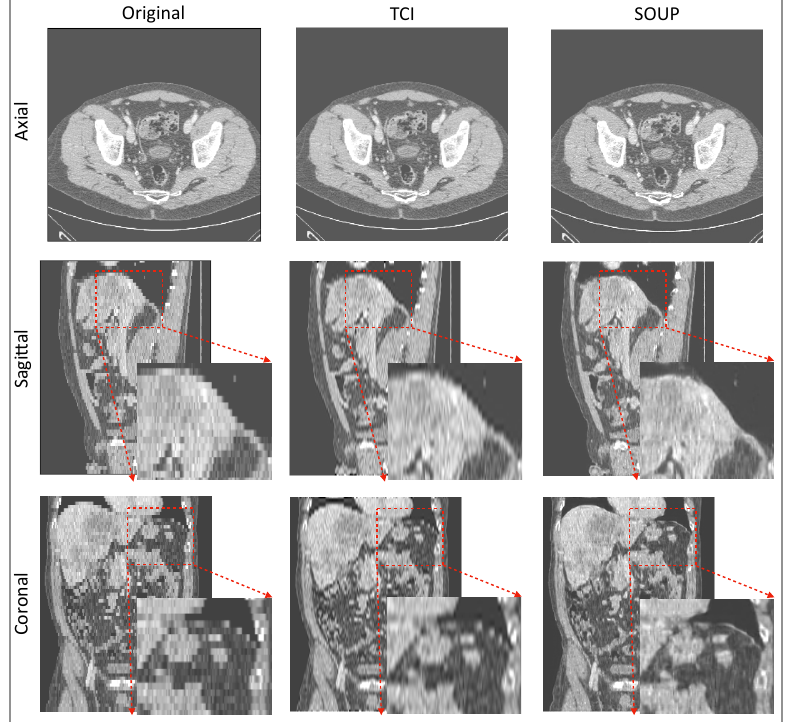
Figure 7. Another example of SR interpolation on CT data with a sampling factor equal to 5.72. TCI: tricubic